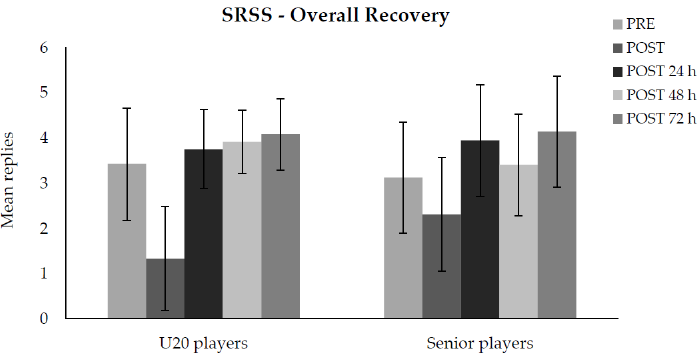
Figure 5. Mean replies to SRSS subscale “overall recovery” of U20 and senior handball players as a function of measurement time point (PRE, POST, POST 24 h, POST 48 h, POST 72 h).